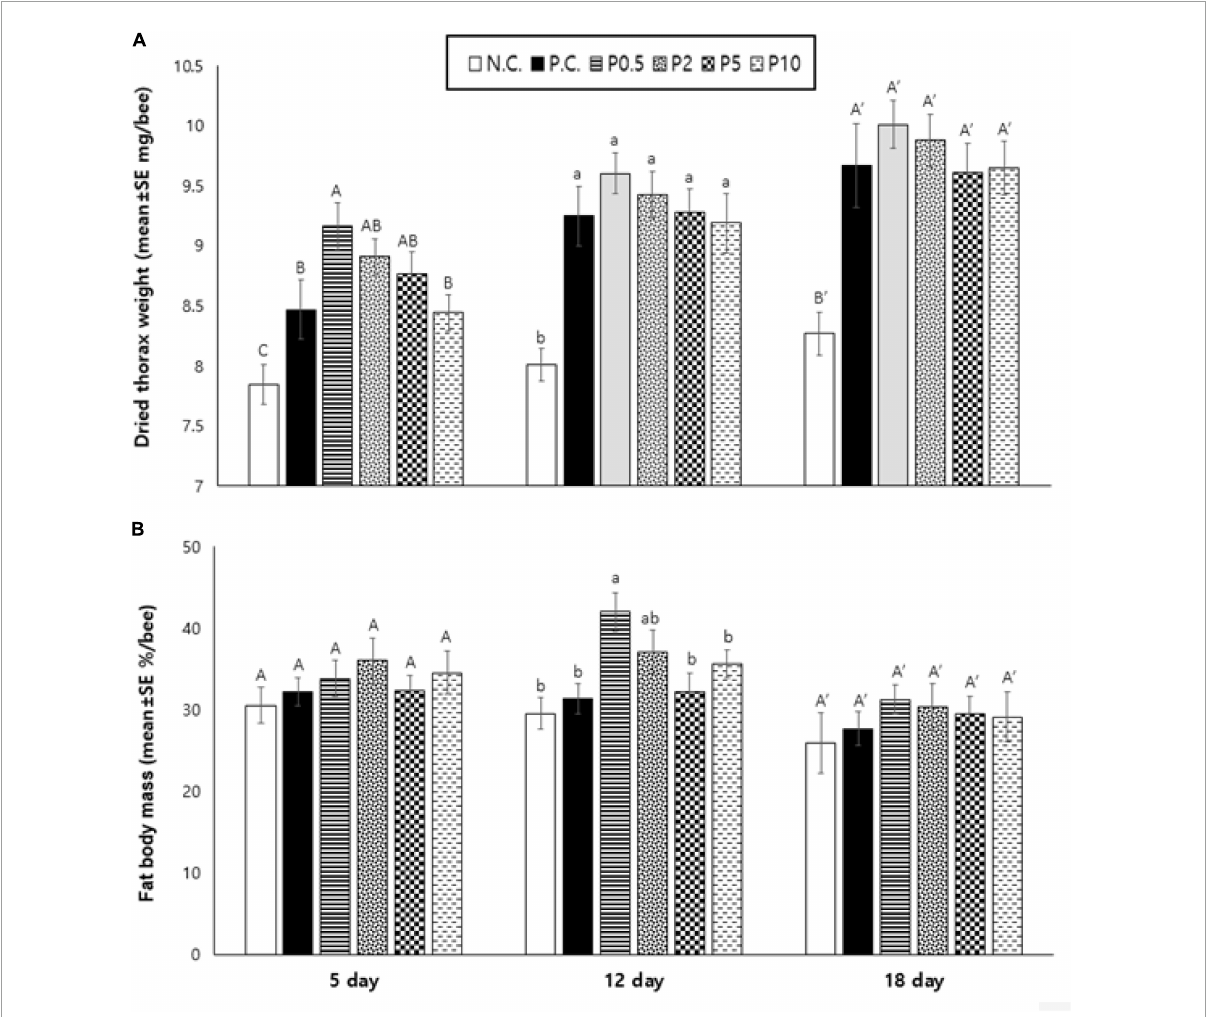
FIGURE6 (A) Dried thorax weight (mean ± SE mg/bee) and (B) fat body mass (mean ± SE%/bee) measured on days 5, 12, and 18 in caged honey bees fed with different diets. NC means negative control; PC means positive control. Different letters over the bar indicate statistically significant differences ( p <